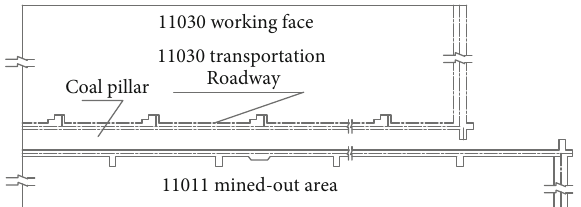
Figure 10: The layout plan of carrying roadway along 11030 working face.